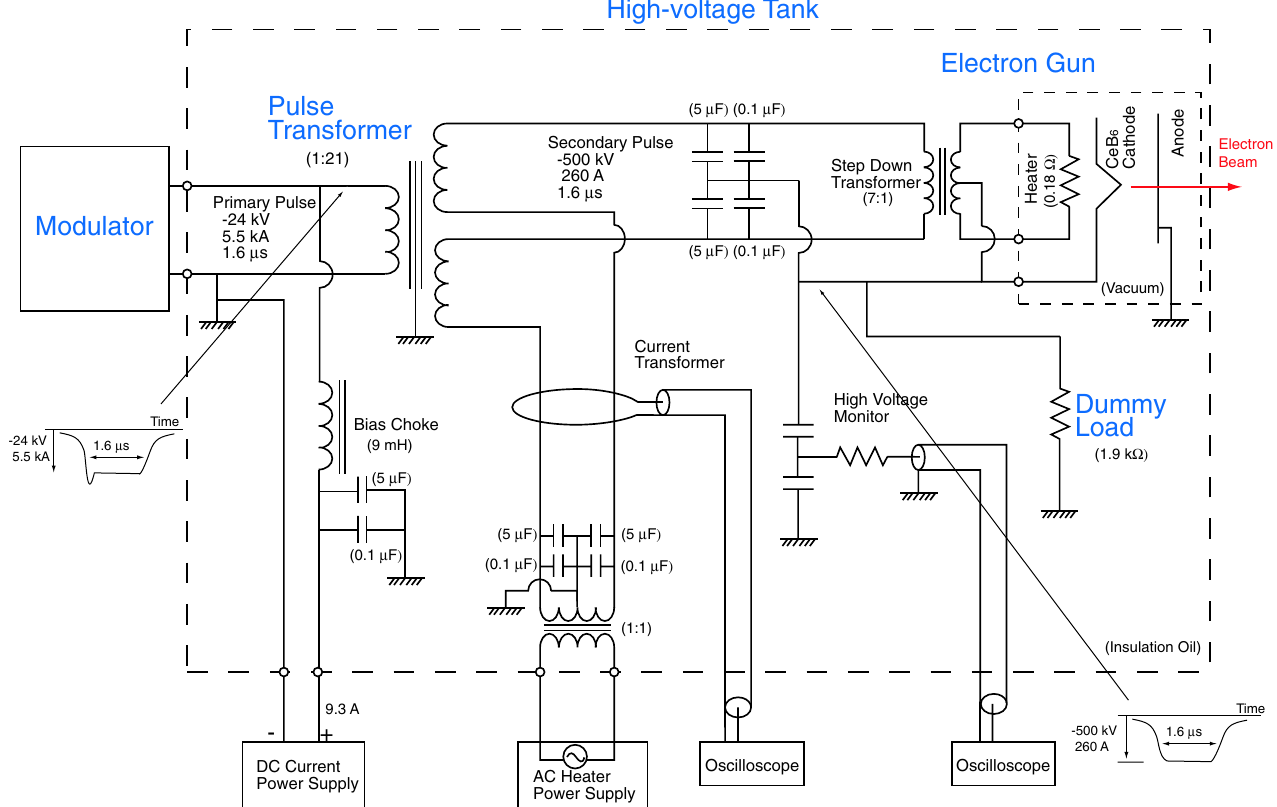
FIG. 4. (Color) Circuit diagram of the gun high-voltage